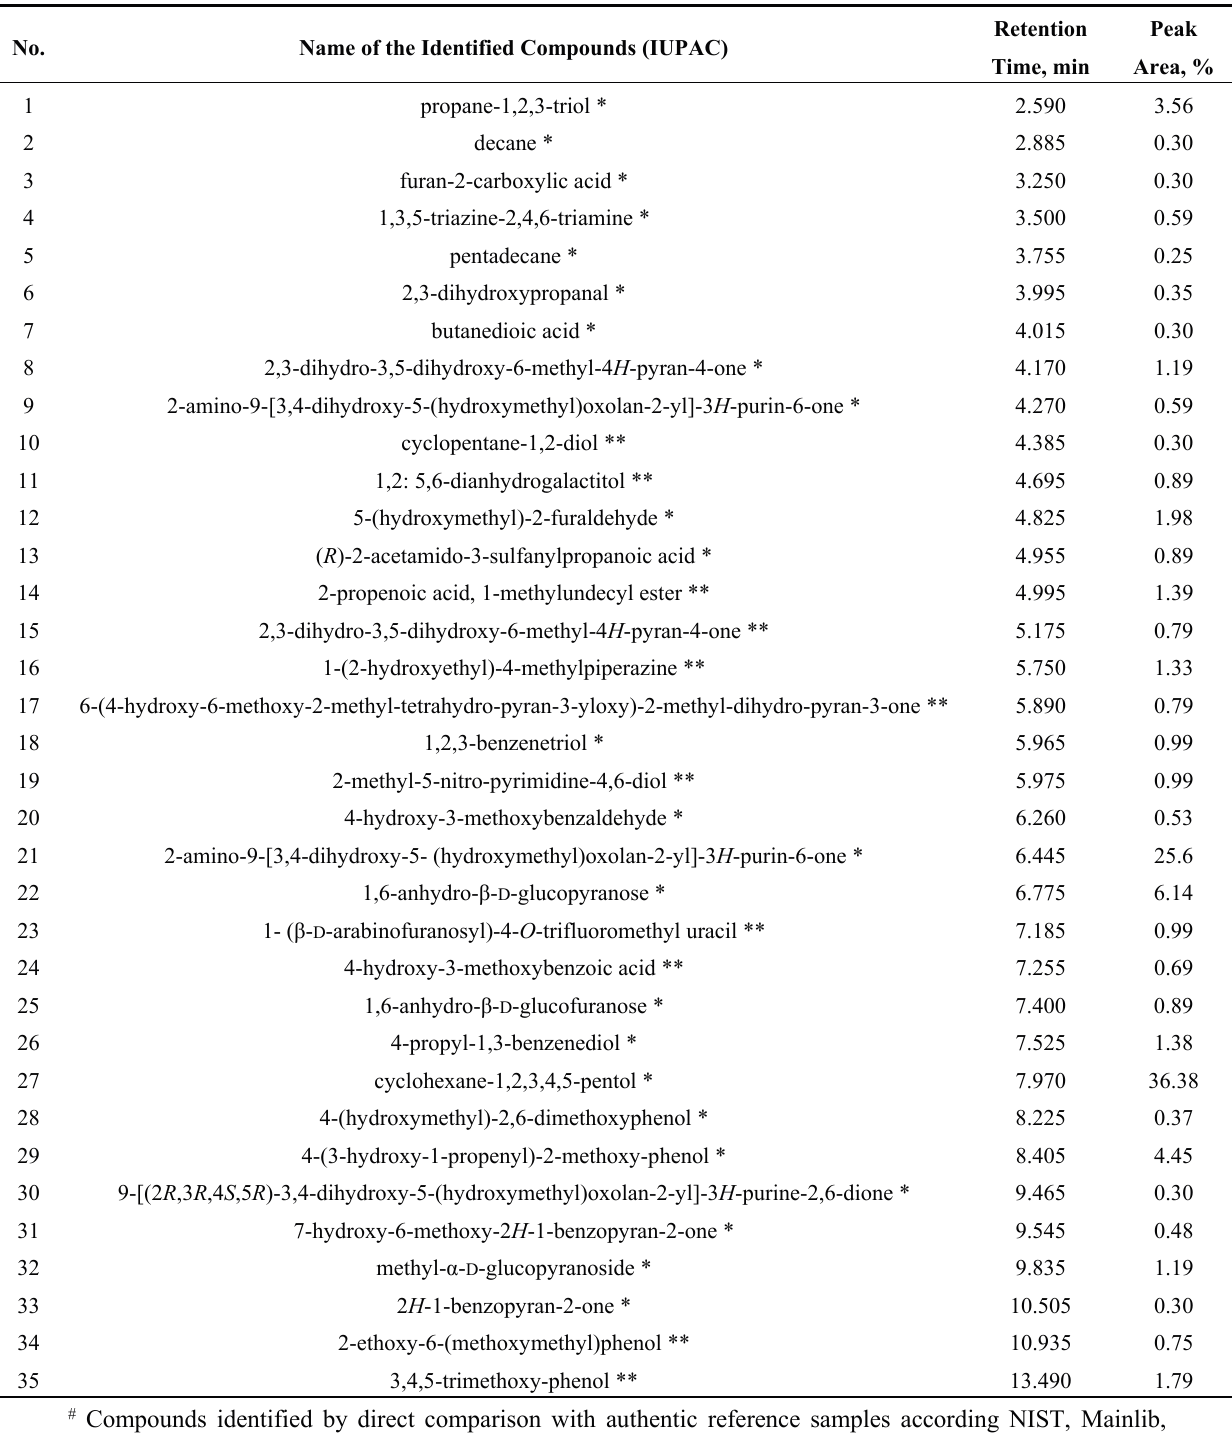
Table 1. The phytochemicals identified in the Quercus cortex extract by gas chromatography-mass spectrometry #